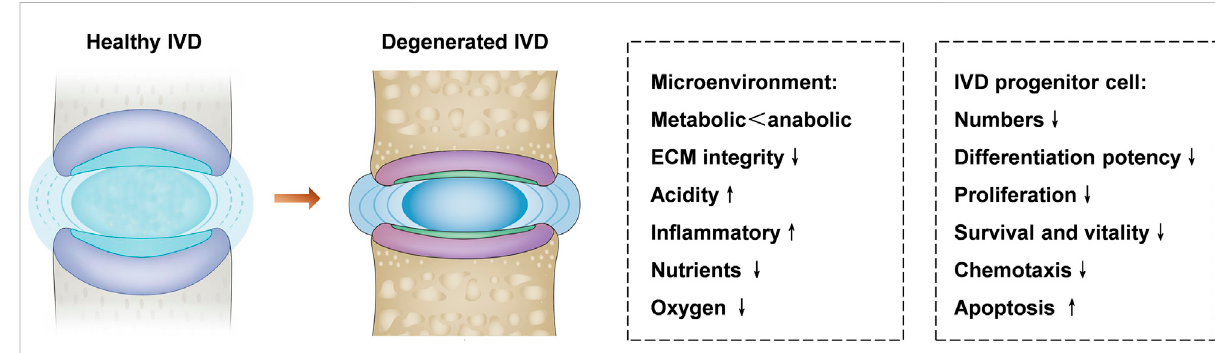
FIGURE 2 IVD microenvironment changes and IVD progenitor cells in healthy and degenerated IVD. The microenvironment of the degenerated IVD is characterized by metabolic disorders, acidic, in fl ammatory, poor nutrient supply, and low oxygen level, which offer a hostile microenvironment for IVD progenitor cells. Degenerative disc disease can lead to decreased differentiation potency, survival, chemotaxis, and proliferation of the IVD progenitor cells, the hostile microenvironment in the IVD might be unfavorable to the activity of progenitor